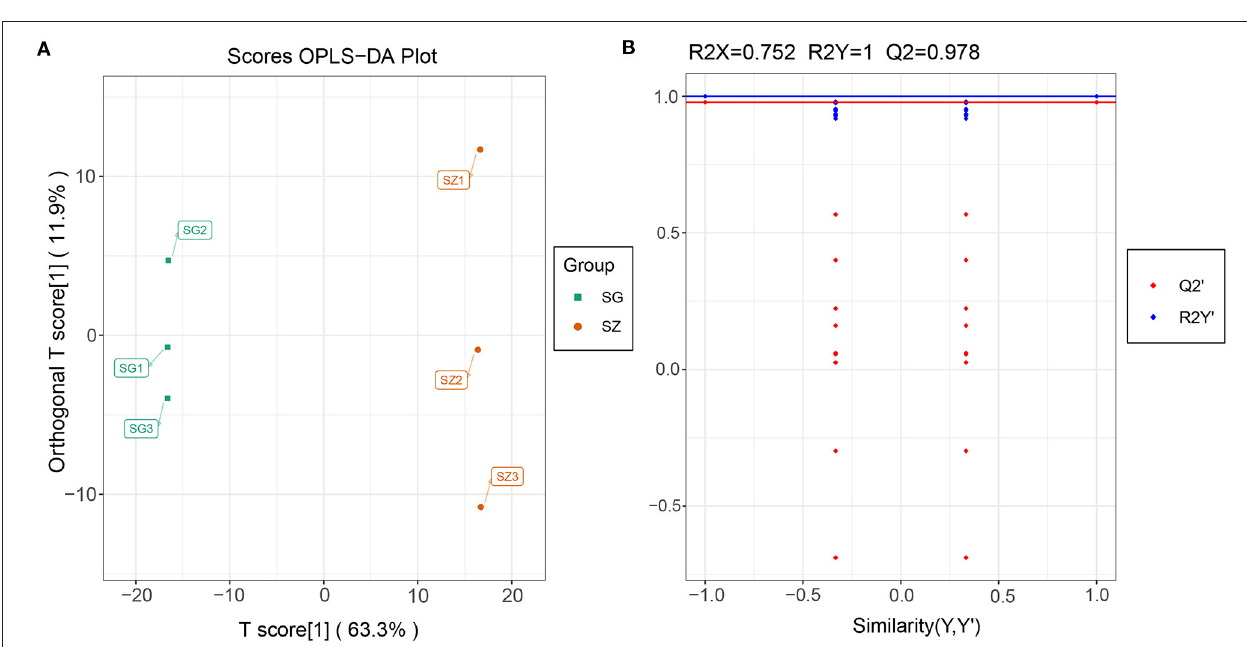
FIGURE 6 | Metabolomics profiling of SG_vs_SZ group. (A) Orthogonal partial least squares-discriminant analysis (OPLS-DA); (B) The 200-response sorting tests of the OPLS-DA model, Q2 is an important parameter for evaluating the OPLS-DA model, and the R2X and R2Y represent the percentage of OPLS-DA model that can explain X and Y matrix information,